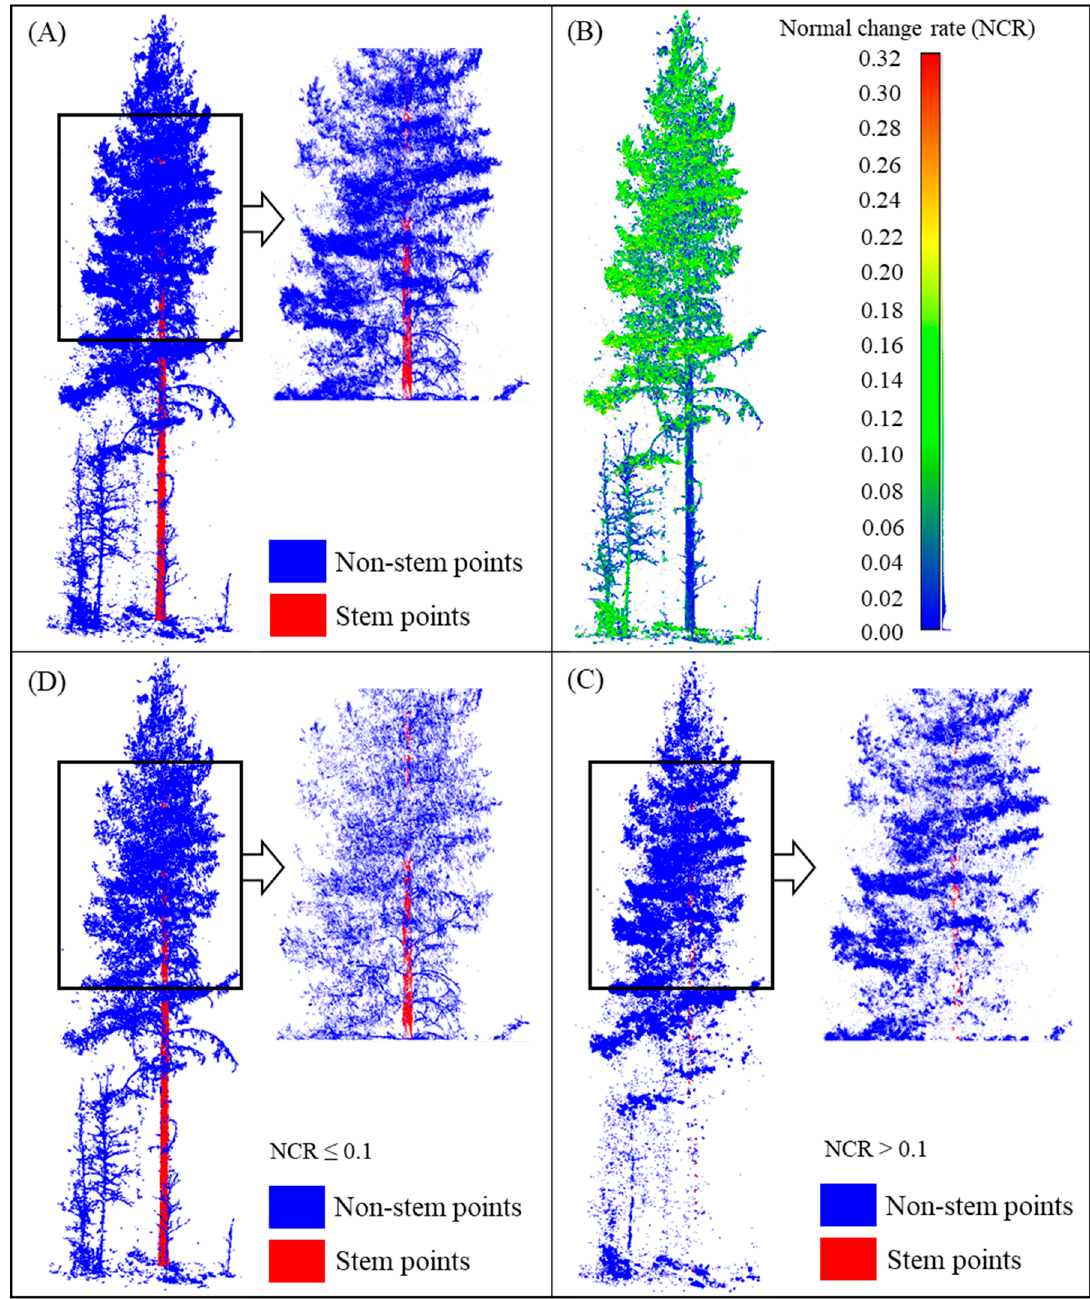
Figure 4. Illustration of the branches and foliage (B&F) points thinning based on normal change rate (NCR). ( A ) The original point cloud. ( B ) The NCR of each point was calculated using a 5 cm neighborhood size. ( C ) The points with an NCR exceeding 0.1 were removed from the original point cloud. ( D ) The remaining points where the NCR did not exceed 0.1. The figure shows that the original point cloud was thinned after removing a part of B&F points based on a threshold of NCR. Most stem points were retained, but a few of them were wrongly removed.